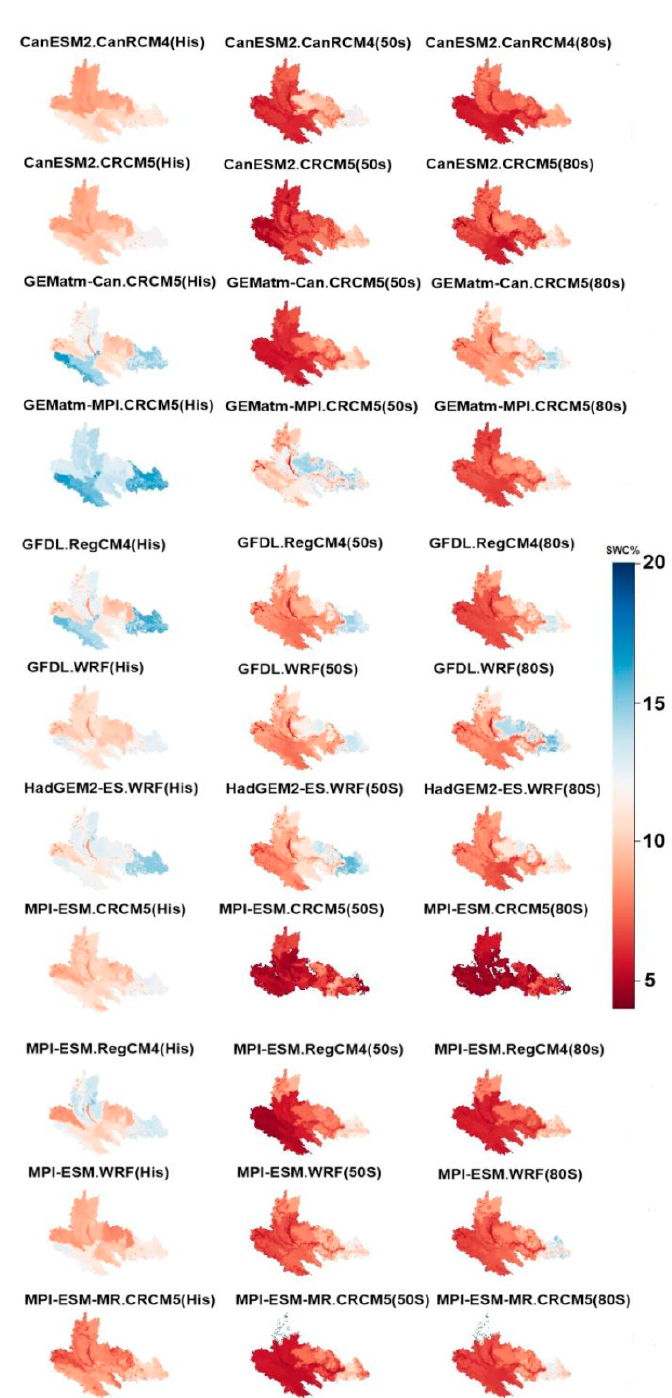
Figure 10. Annual spatial SWC in the historical period, and middle and late century. Figure 11 gives the spatial change in SWC in terms of the number of pixels in three categories: improved soil water content (positive), a loss of soil water content (negative), and no significant change. Among all models, only 5% of the region gains SWC, 27% has no significant change, and 68% of the region has a loss of SWC.